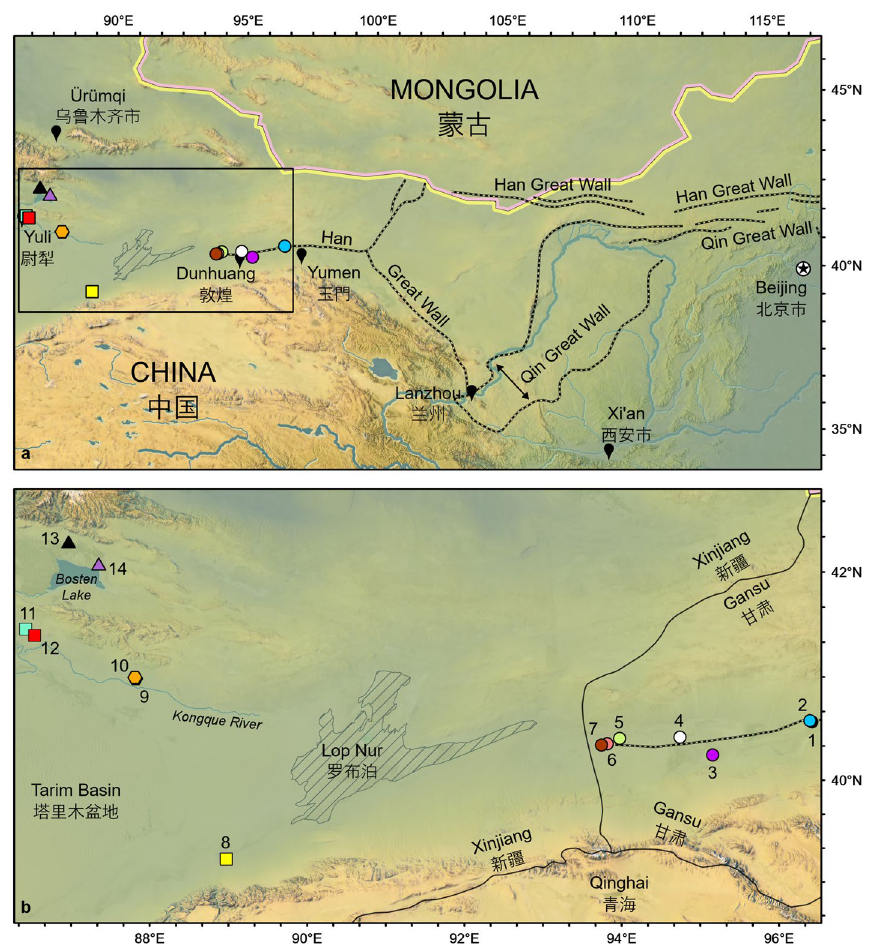
Figure 1. Location of the study area in northwestern China. ( a ) Extent of Qin and Han Great Wall segments across northern China. ( b ) Site locations in Gansu and Xinjiang: (1) Han Dynasty Great Wall segment; (2) Beacon tower near Site 1; (3) Beacon tower near Guazhou town; (4) Xijiandun Beacon Tower; (5) Cang Ting Sui Beacon Tower at Yumenguan; (6) Great Wall Heritage Site; (7) Majuanwan Great Wall segments; (8) Milan Castle Heritage Site; (9) Buddha Tower, south end of the Yingpan City Heritage Site; (10) City wall, north end of the Yingpan City Heritage Site; (11) Yakelun Beacon Tower; (12) Sunji Beacon Tower; (13) Tahaqi Beacon Tower; (14) Sishilidadun Beacon Tower. Circles date to the Han Dynasty, hexagons to the Jin Dynasty, squares to the Tang Dynasty, and triangles to the Song Dynasty. Maps were created using ArcGIS Pro desktop GIS software developed by